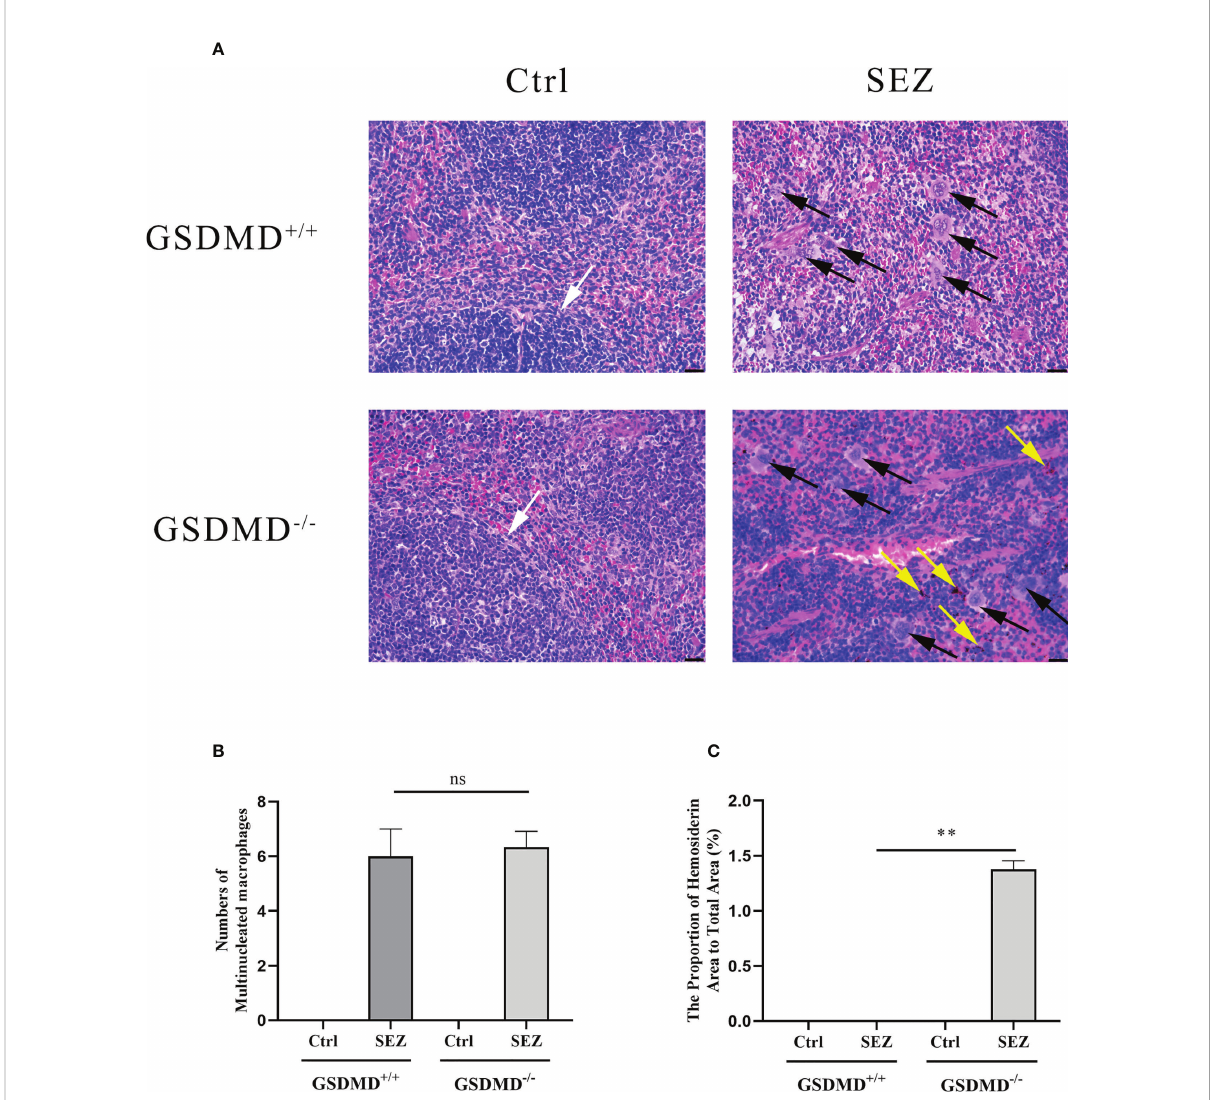
FIGURE 2 GSDMD de fi ciency results in enhanced pathology but not macrophages number in the spleen during SEZ infection. GSDMD +/+ and GSDMD -/- mice (n=3) were treated with SEZ (10 6 CFU) or equivalent PBS for 24 h. The black arrow marks the multinucleated macrophages. The yellow arrow indicates hemosiderin. The white arrow points to the clear white pulp of the spleen. One representative experiment of three is shown. Scale bar, 25 m m (A, B) The number of multinucleated macrophages was calculated in the microscopic fi elds of the slides. (C) The proportion of hemosiderin area to total area was calculated by randomly selecting three microscopic fi elds. These experiments were conducted with 3 replicates. Data are expressed as mean ± SD. ns, not signi fi cant, ** p <0.01, one-way ANOVA (B, C)